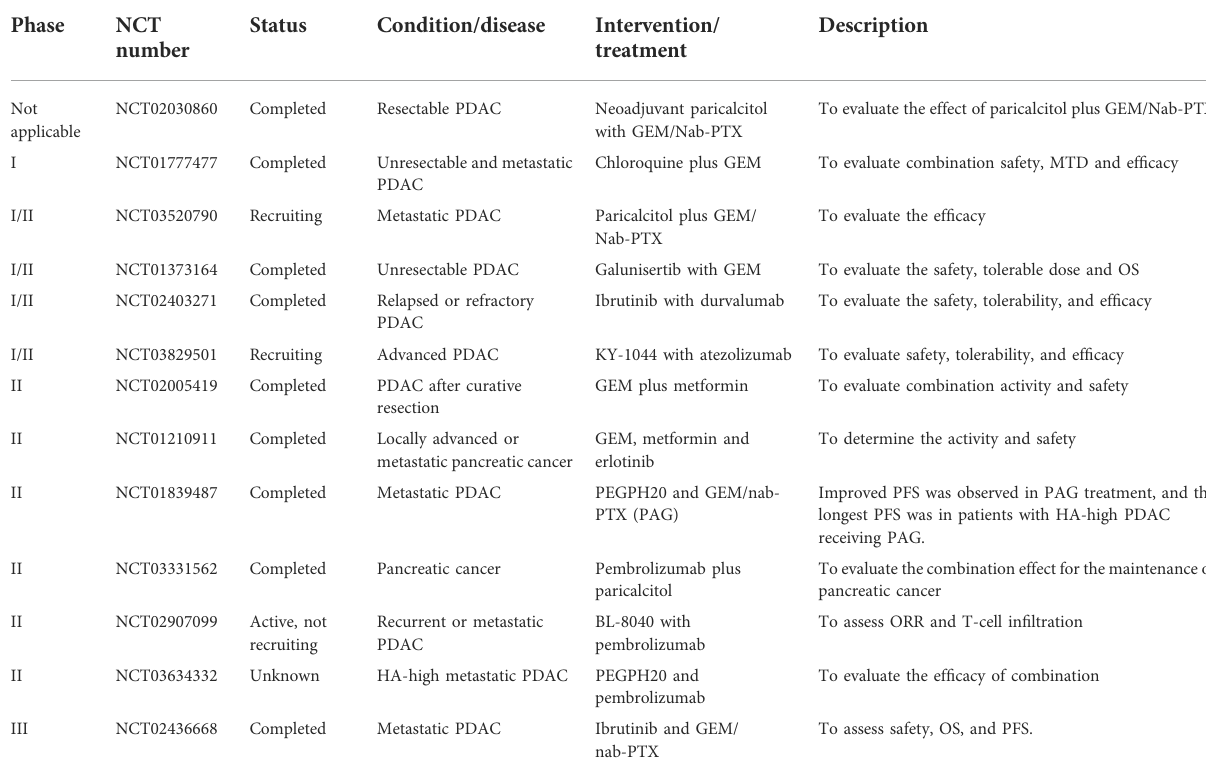
TABLE 1 Clinical trials of strategies for conditioning the PDAC